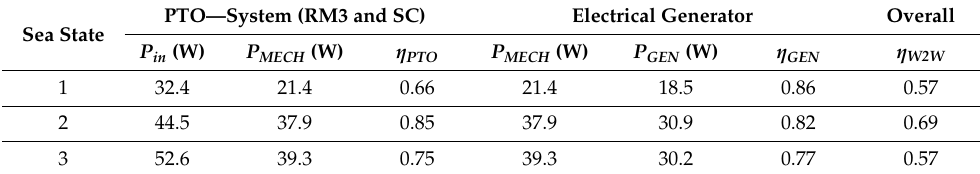
Table 9. Efficiencies at different stages of energy conversion chain for irregular waves. PTO—System (RM3 and SC) Electrical Generator Sea State